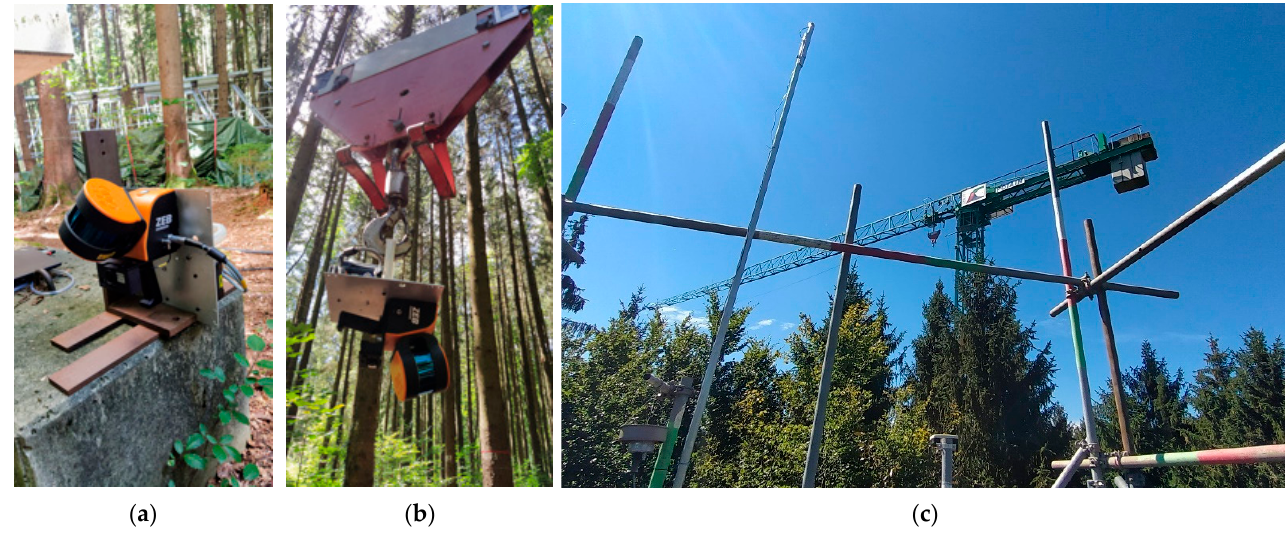
Figure 1. The mobile laser scanner in the start position ( a ) and attached to the crane ( b ). During operation, it was lifted over the canopy and moved smoothly over the canopy of the forest stand. Figure ( c ) shows the crane itself.